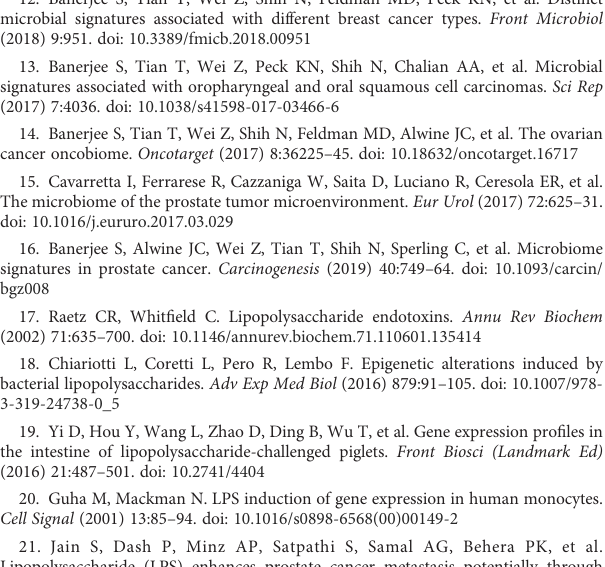
SUPPLEMENTARY FIGURE 1 Prediction of coexpression network of LRHG on GeneMANIA. SUPPLEMENTARY FIGURE 2 Correlation between risk score and sensitivity of bicalutamide and docetaxel based on TCGA cohort (n=476). (A) Bicalutamide drug sensitivity; (B) Docetaxel drug sensitivity; (C) AR mRNA expression. * P < 0.05; * * P < 0.01; *** P <